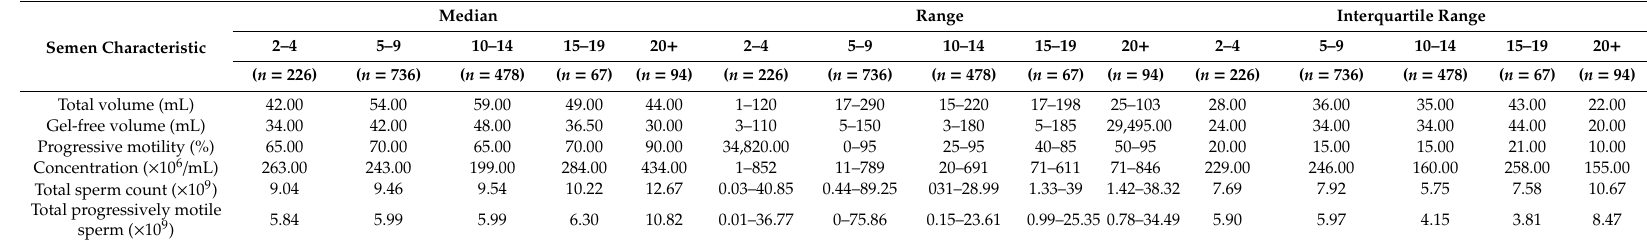
Table 1. Medians, ranges and interquartile ranges for each semen characteristic among age categories of competing and non-competing stallions.